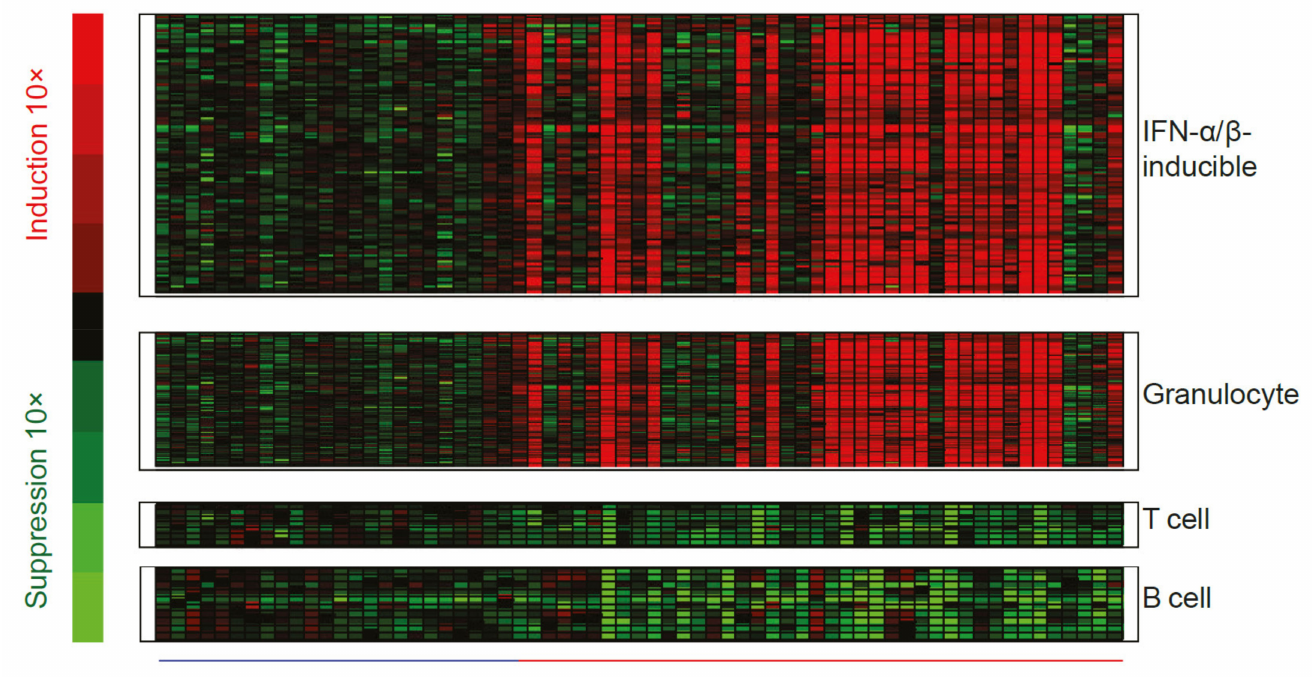
Figure 4. Representative heat map visualizing genes differentially expressed in whole blood from patients with SLE relative to healthy controls. The heatmap includes 110 upregulated interferon- α / β -inducible transcripts, measured in whole blood samples from patients with SLE (—; n = 41) and compared with whole blood samples from healthy controls (—; n = 24). Figure reproduced from Yao et al. Hum Genomics Proteomics 2009, 374312 [54]. IFN, interferon; SLE, systemic lupus